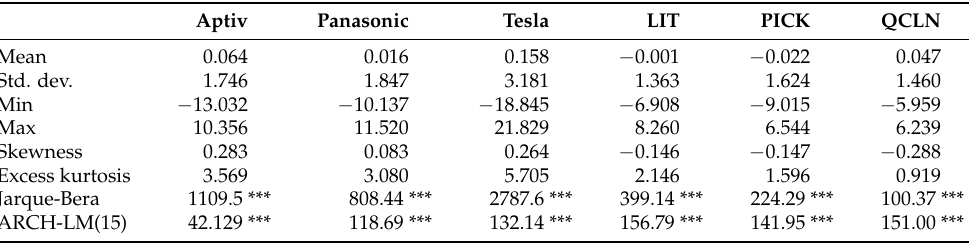
Table 1. Descriptive statistics of logarithmic price